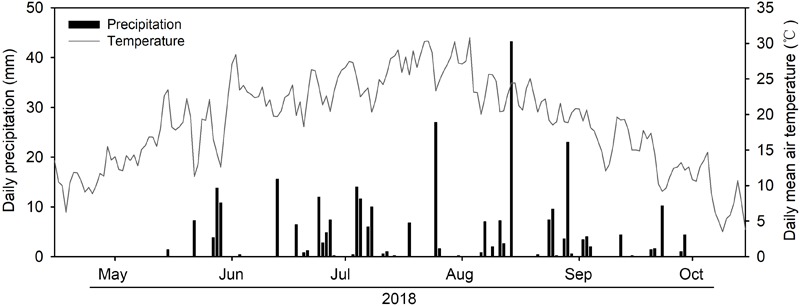
Daily precipitation (bars, mm) and daily mean air temperature (lines, °C) of growing season (May to October) in 2018.